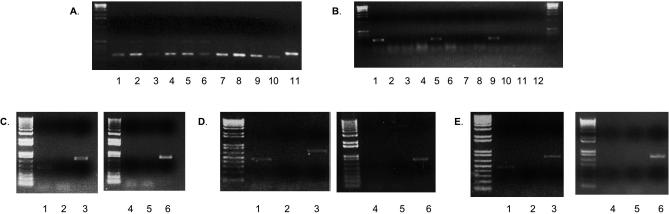
Expression Study Results for the Bällchen and Hun gene(A) Bällchen is expressed ubiquitously in both D.melanogaster and D. simulans: whole body, D. melanogaster (1), D. simulans (2); head, D. melanogaster (3), D. simulans (4); thorax, D. melanogaster (5), D. simulans (6); testes, D. melanogaster (7), D. simulans (8); and accessory gland with ejaculatory duct, D. melanogaster (9), D. simulans (10). Lane 11 is a genomic control.(B) RT-PCR results for Hun from adult male and female D. simulans, D. mauritiana, and D. sechellia flies. Hun's expression is limited to D. simulans, D. mauritiana, and D. sechellia males, lanes 1, 5, and 9, respectively. Lanes 3, 7, and 11 are (D) D. simulans, D. mauritiana, and D. sechellia females. Lanes 2, 4, 6, 8, 10, and 12 are corresponding RT-controls. (C–E) Tissue specific RT-PCR results for the Hun gene in D. simulans (C), D. mauritiana (D), and D. sechellia (E). For these RT-PCR experiments testes were dissected from the rest of body. Hun's expression is testes-specific for each species: testes, lane 1; RT-control, lane 2; Gapdh-2 positive control, lane 3; rest of body, lane 4; RT-control, lane 5; Gapdh-2 positive control, lane 6.